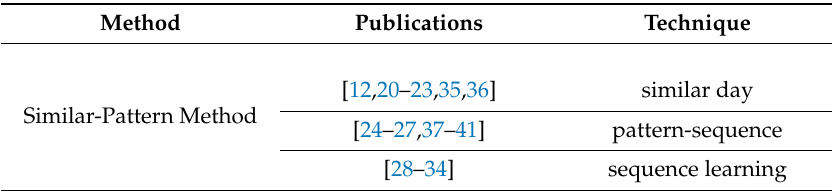
Table 2. Published articles employing similar-pattern